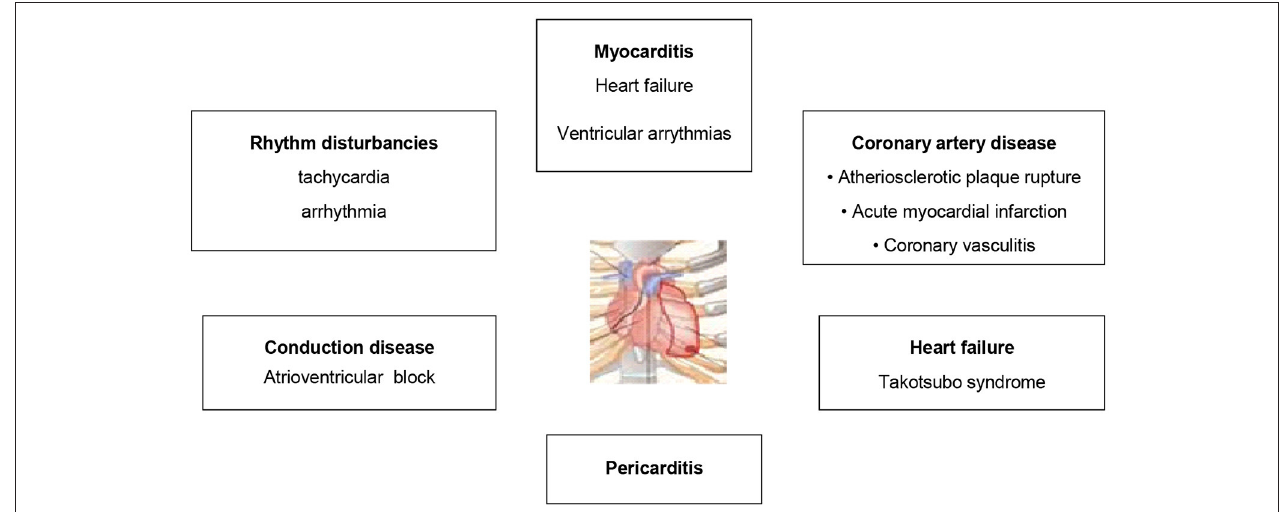
FIGURE 1 | Main clinical types of cardiac involvement during treatment with immune checkpoint